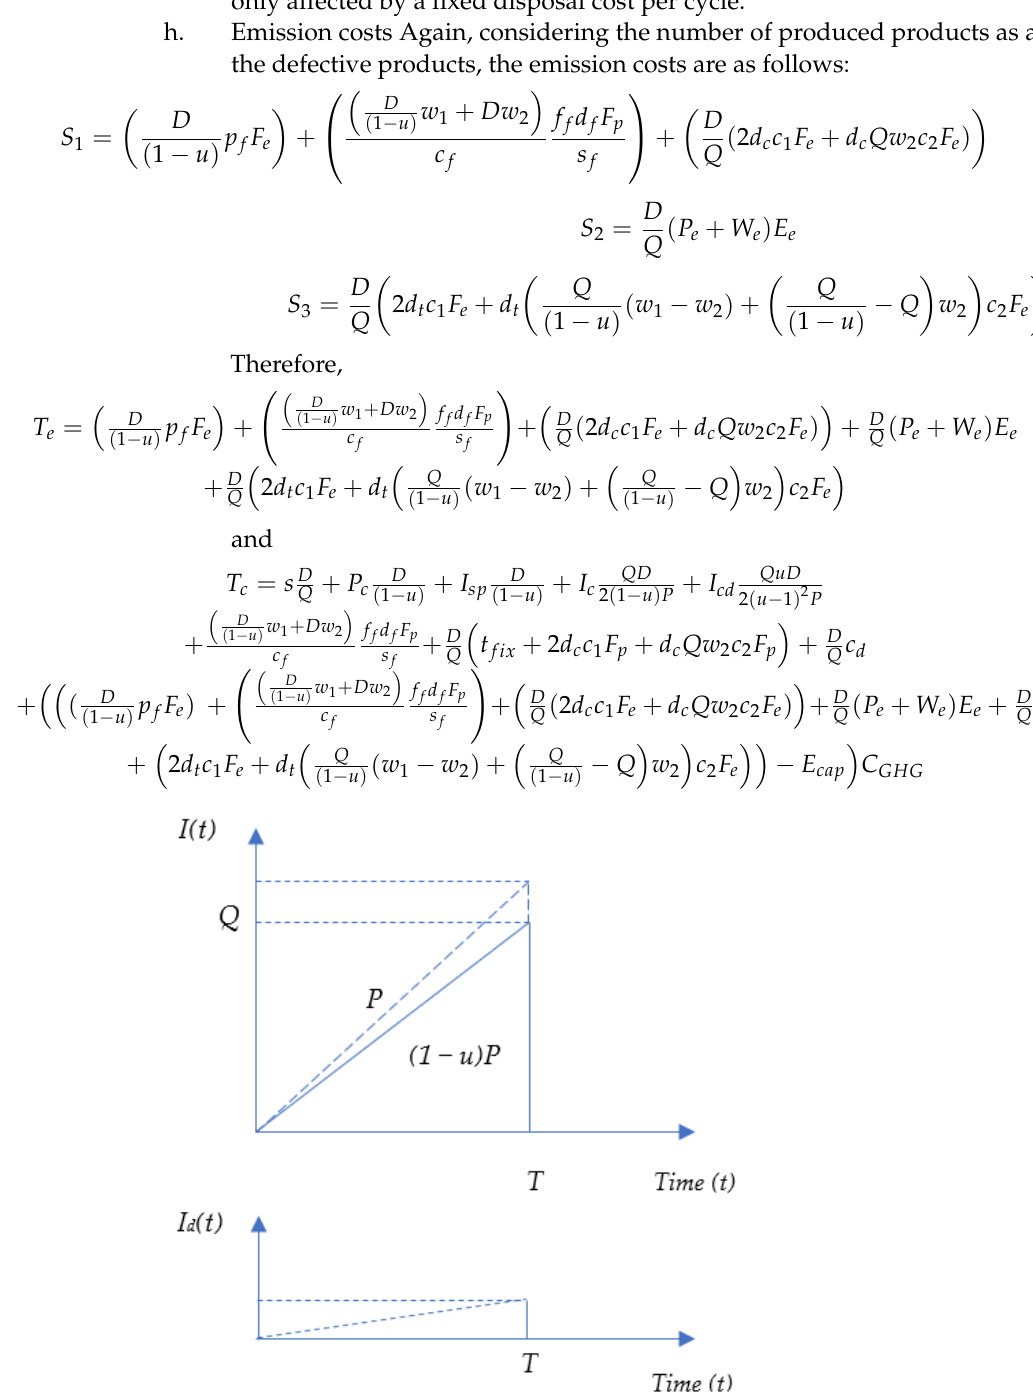
Figure 3. Inventory of the conforming ( top ) and defective products ( bottom ).